Question: Describe this figure in one sentence.
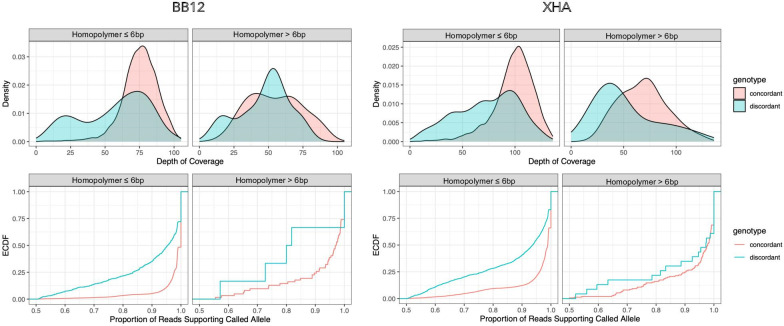
Answer: Variant quality metrics for discordant and concordant Nanopore genotype calls in both long homopolymeric (>6 bp) and short/non-homopolymeric (≤6 bp) regions for laboratory isolates: ( a ) BB12 and ( b ) XHA. Density plots show distributions for the depth of coverage by locus. Calls are labelled concordant or discordant based on agreement with Illumina genotypes at the same locus. Density plots show read depth distributions by locus. Empirical cumulative distribution functions (ECDFs) show distributions for the proportion of reads supporting the called allele. Left-shifted curves indicate lower support for detected alleles. In both homopolymeric and non-homopolymeric regions, discordant calls frequently had a smaller proportion of reads supporting the called allele than concordant calls.